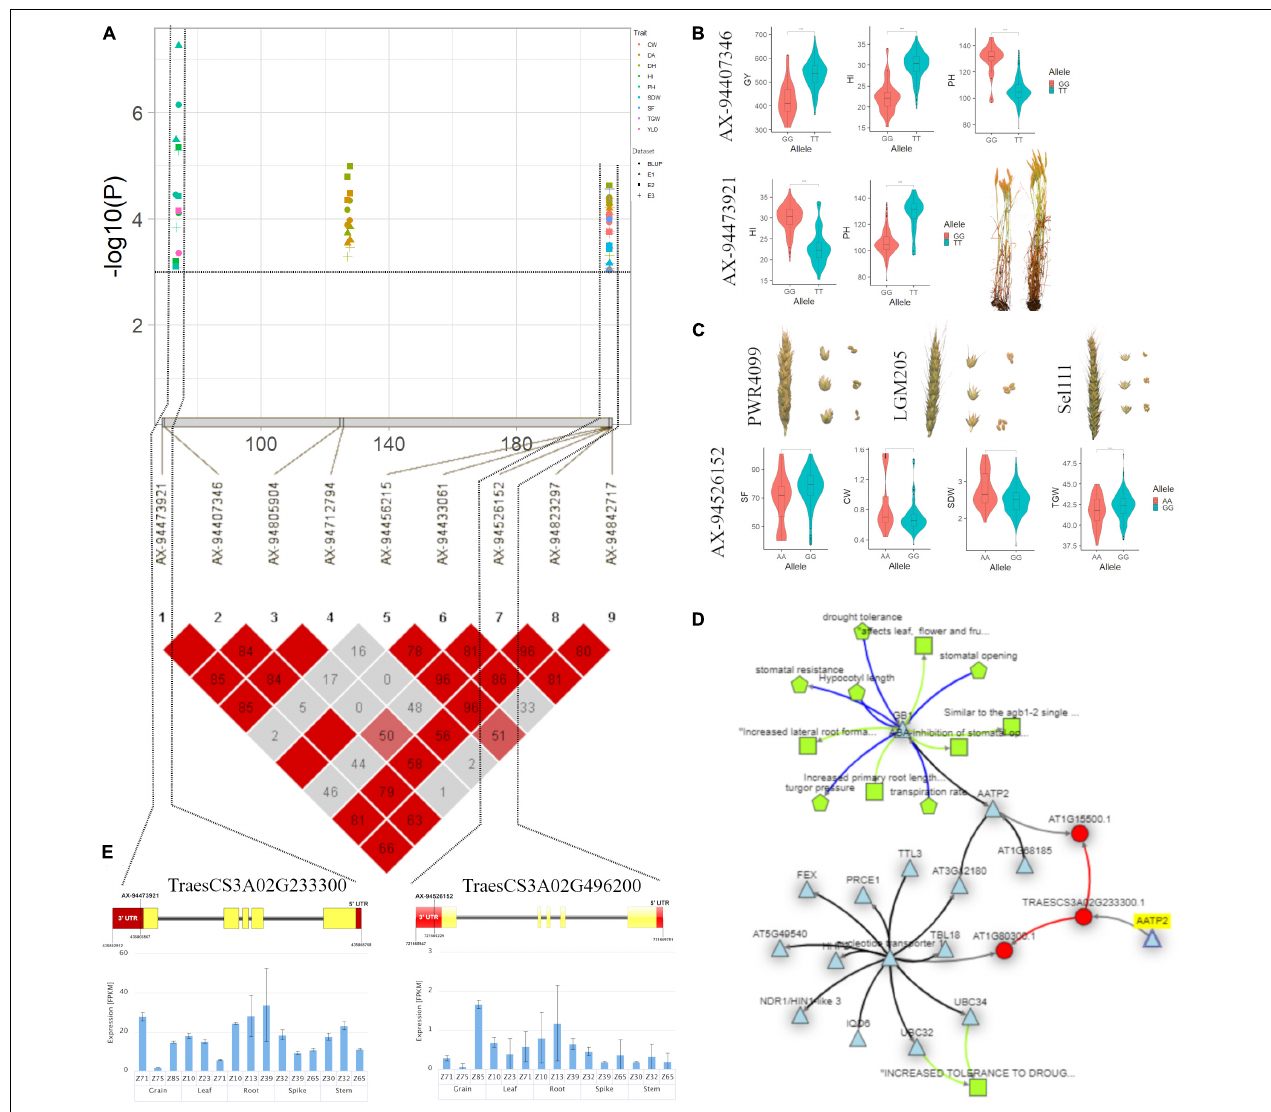
FIGURE 5 | (A) Local Manhattan plot and linkage disequilibrium (LD) heatmap of stable SNPs associated with grain yield (GY), harvest index (HI), plant height (PH), spike fertility (SF), chaff weight (CW), spike dry weight (SDW), and thousand-grain weight (TGW) on chromosome 3A. (B) Effect of different alleles of associated SNP markers on the phenotypic values of GY, HI, and PH. (C) Effect of different alleles of marker AX-94526152 on phenotypic values of SF, SDW, CW, and TGW. (D) Network generated for gene TraesCS3A02G233300 (AATP2). (E) Structure of two candidate genes and their in silico tissue and growth specific expression